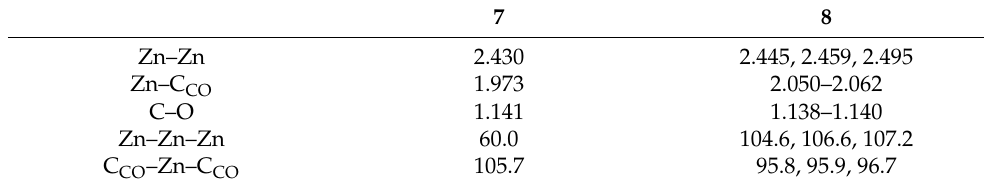
Figure 3. Optimized structures of complexes 7 and 8 , isolobally related to cyclopropane and cyclopentane, respectively. Table 3. Selected structural parameters (bond distances, Å, and angles, °) of complexes 7 and 8 .